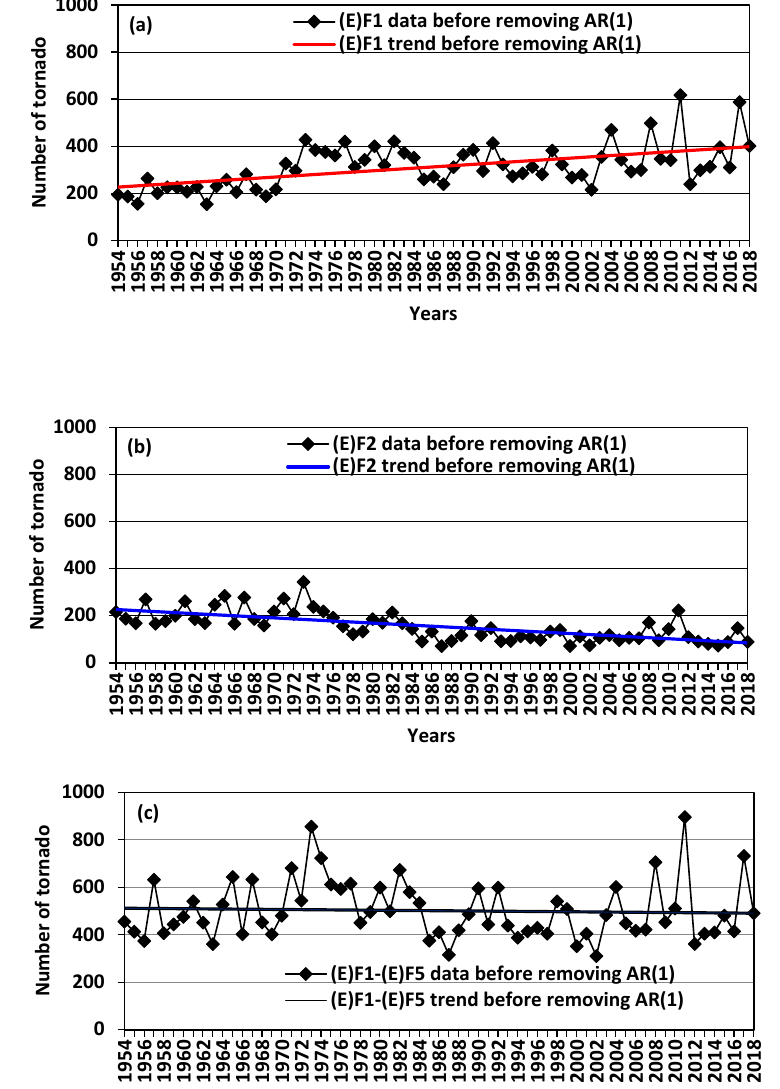
Figure 3. Time series of U.S. tornado counts (1954–2018) and its trend after adjustment associated. with population density for ratio of (E)F1 to (E)F2 in ( a ) decreasing (E)F1 over 1954–1973, ( b ) increasing (E)F2 over 1954–1973, and ( c ) (E)F1–(E)F5 with (E)F1 in ( a ) and (E)F2 in ( b ).